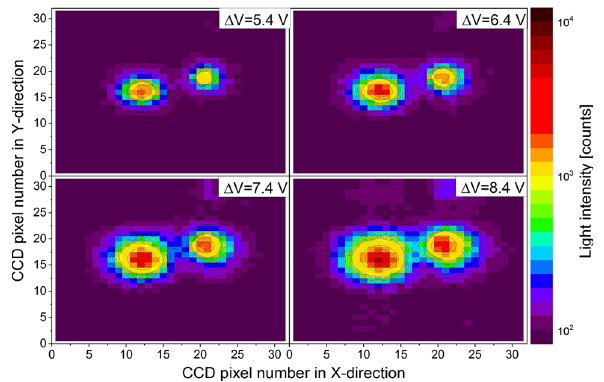
Fig. 9 Example of the increase in lateral expansion of hotspots with Δ V for a KETEK PM3350T STD ( t sponds to 10 . 43 µ m 2 of the SiPM area